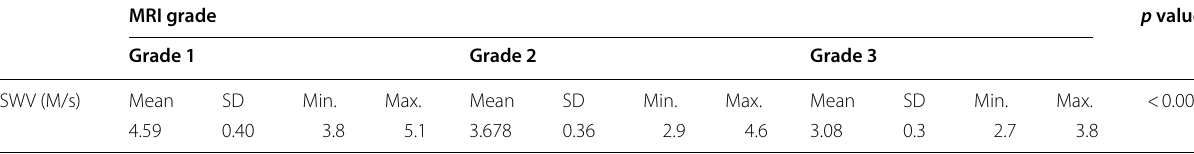
Table 1 Differences in the measured SWV among the different grades of tendon abnormality MRI grade p value Grade 1 Grade 2 Grade 3 SWV (M/s) Mean